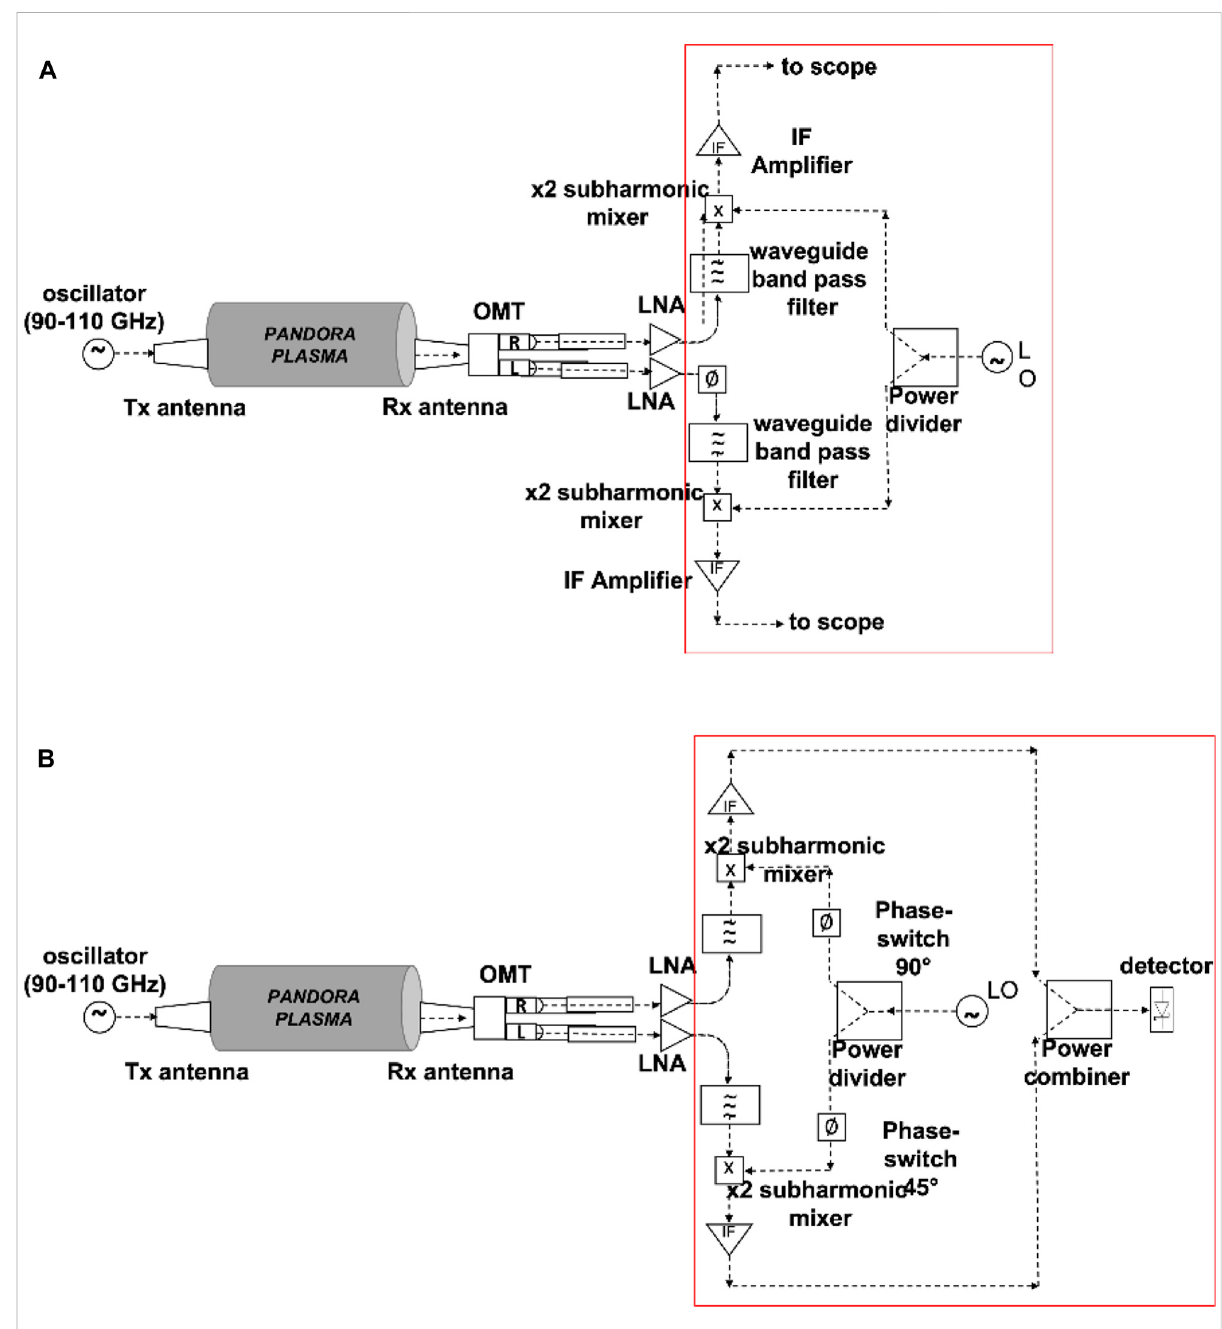
FIGURE 6 (A) Lissajous scheme: simpli fi ed block-diagram of the mm-wave polarimeter for PANDORA. (B) Stokes Parameters detection scheme: simpli fi ed block-diagram of the mm-wave polarimeter for